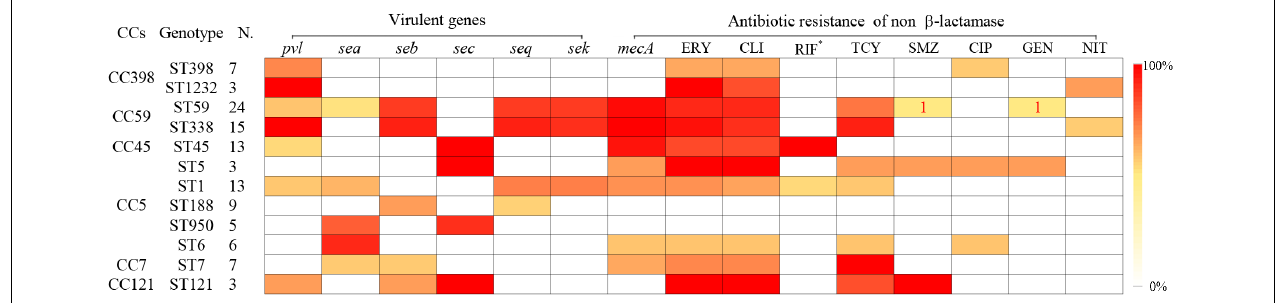
FIGURE 2 | Virulence genes and antigram of S. aureus clinical isolates from women and children are linked to STs, as illustrated by the tri-color scale. If a resistant antibiotic occurred in less than 5% of isolates with a particular ST, the number of S. aureus isolates resistant to the antibiotic is given. ∗ Means rifampicin intermediate